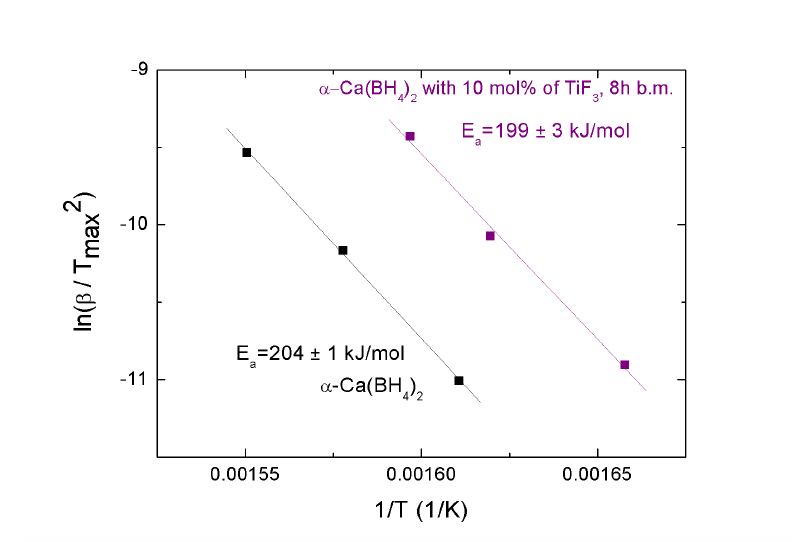
Figure 8. Kissinger plot corresponding to as-received α and α + 10 mol% TiF 3 milled for 8 h.